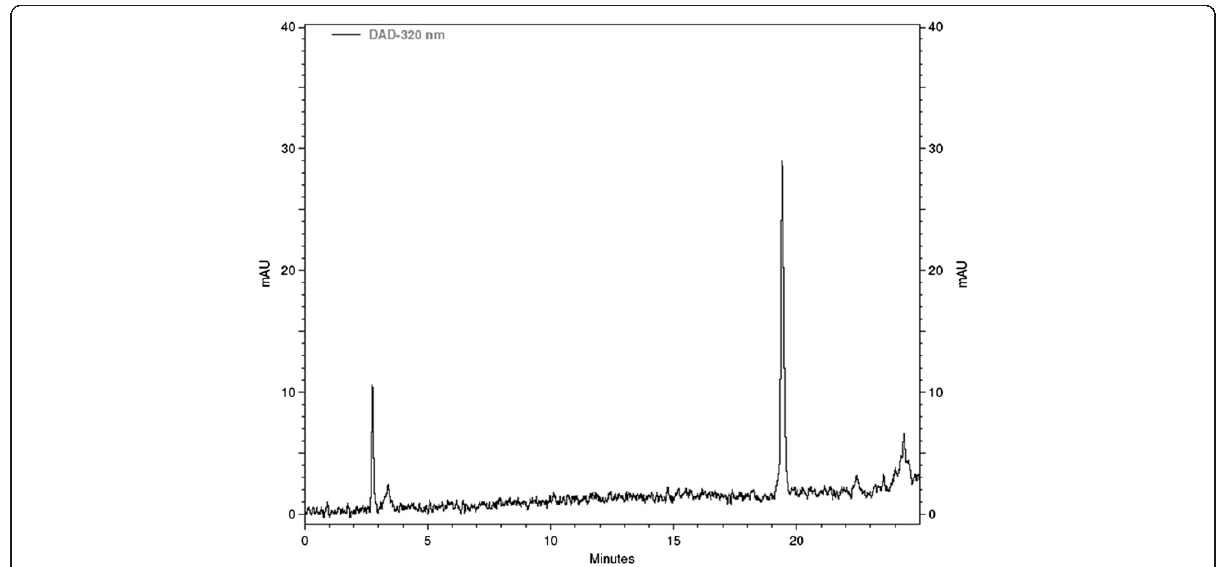
Figure 1 HPLC-DAD phenolic profile for the Sc-EtOH recorded at 320